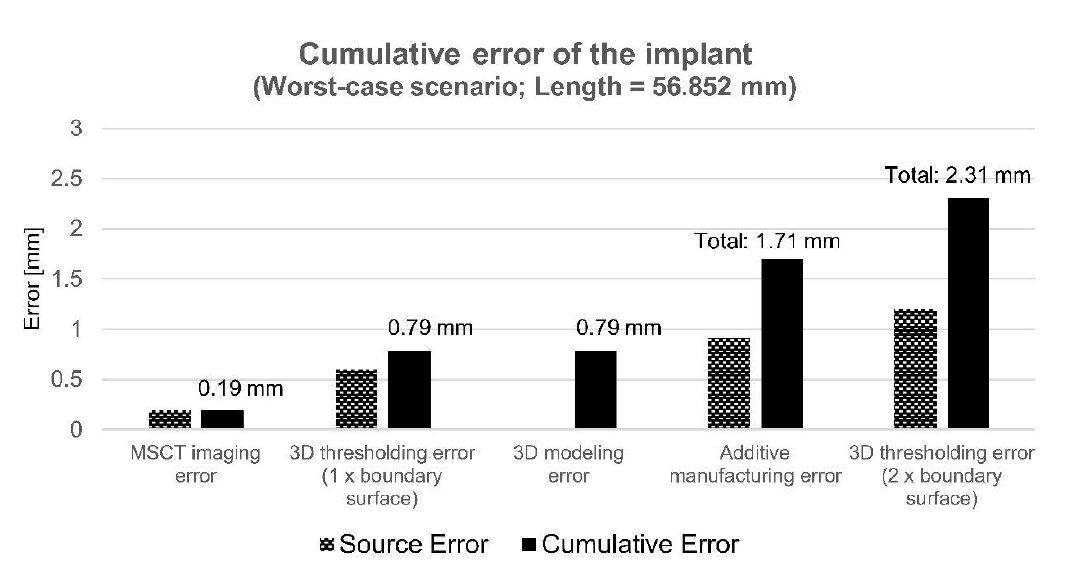
Figure 9. The worst-case cumulative and source error of the end-use implant with a length of 56.852 mm as a function of the whole process chain.